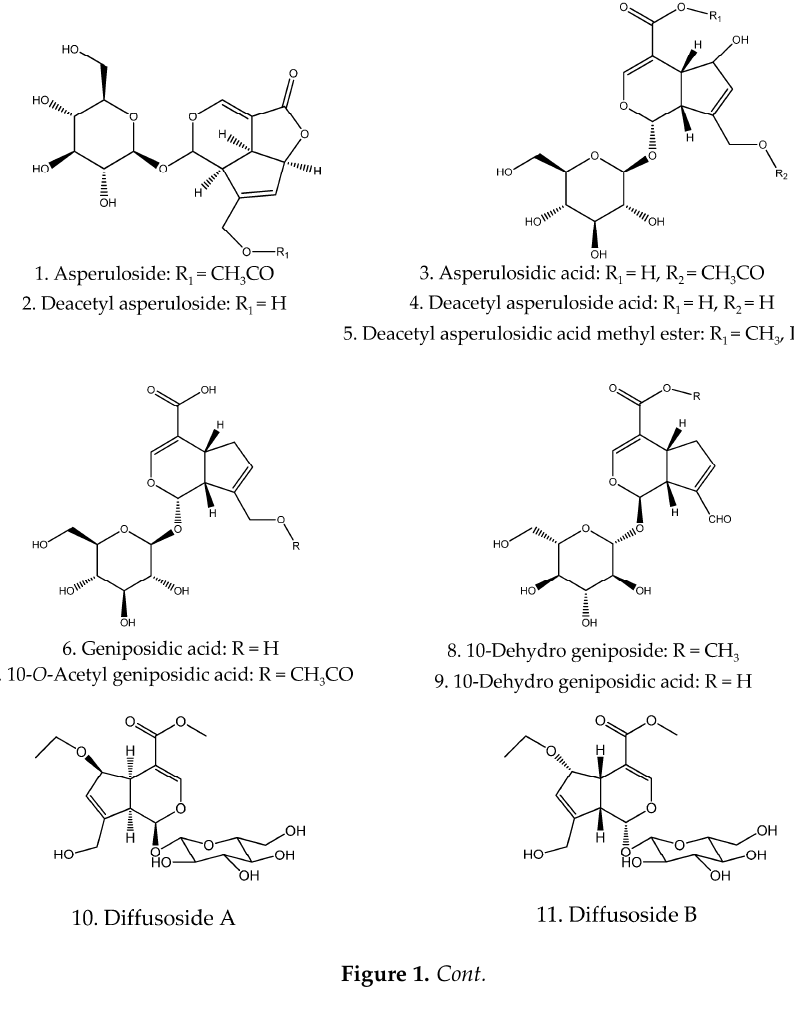
Figure 1. Cont . Figure 1.